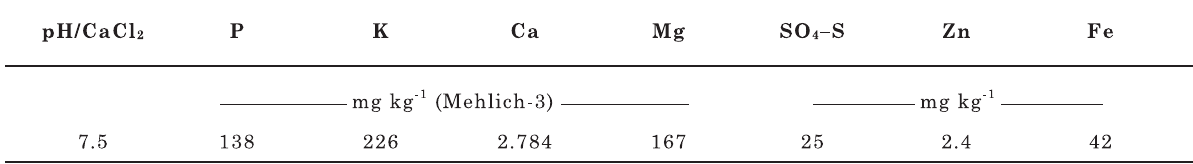
Table 1. Agrochemical characteristic of the